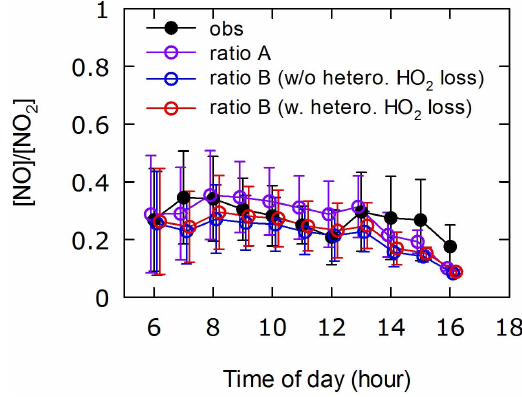
Fig. 10. Average diurnal variations of the observed NO/NO 2 ratio (black) compared with theoretical values assuming photostationary states for the first-half period (till 15 June). For the theoretical val- ues, observed J (NO 2 ) and O 3 concentrations, and peroxy radical concentrations calculated with box model simulations were used. The error bars represent 1 σ ranges of day-to-day variations. See Sect. 6.4 for more